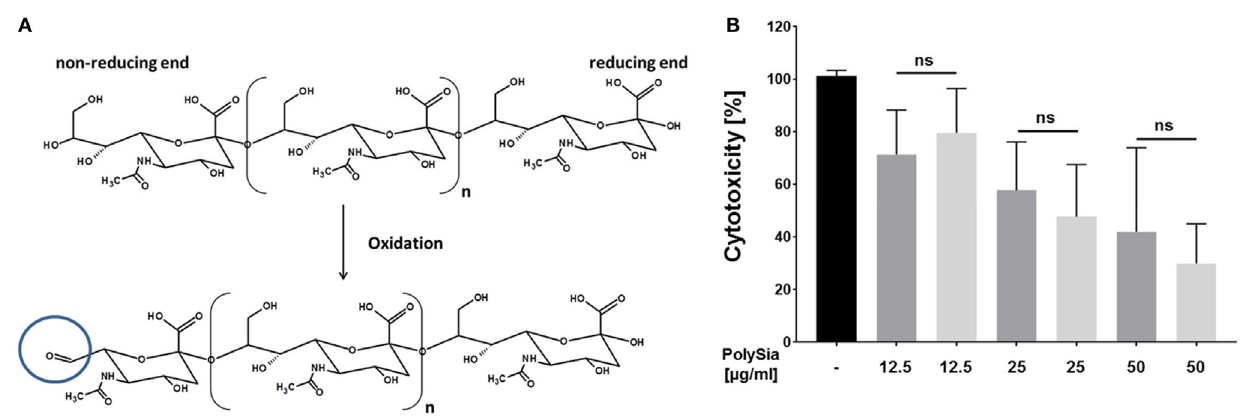
FigUre 3 | Oxidized polySia counteract the cytotoxicity of histones. (a) Illustration of the oxidation of polySia resulting in the formation of a C7 body at the non-reducing end. (B) Native and oxidized polySia were tested for their ability to compensate histone-mediated cytotoxicity. Cells were treated with histones (60 µg/ ml) and the cytotoxicity was determined (black). In parallel, the cytotoxicity was determined in the presence of native (dark gray) and oxidized polySia (light gray). 100% cytotoxicity was set for histone-treated cells. All values are means of three independent experiments. The statistical evaluation was performed by one-way analysis of variance analysis. ns, not significant; * p < 0.05; ** p < 0.01; *** p <